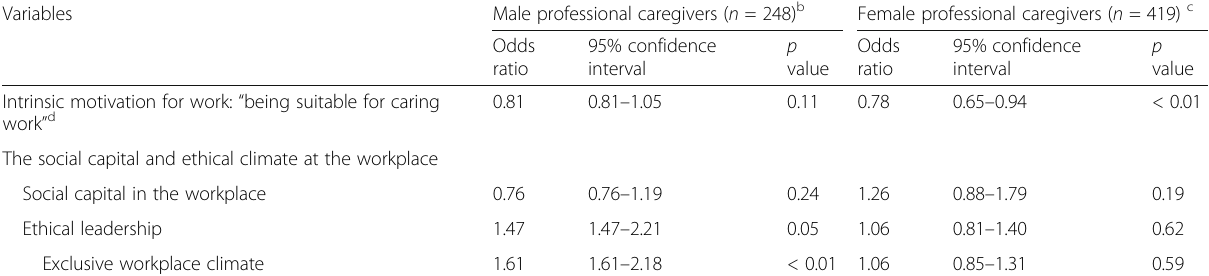
Table 3 Multivariable logistic regression model for experience of work-related accidents and injuries within the prior year according to sex a